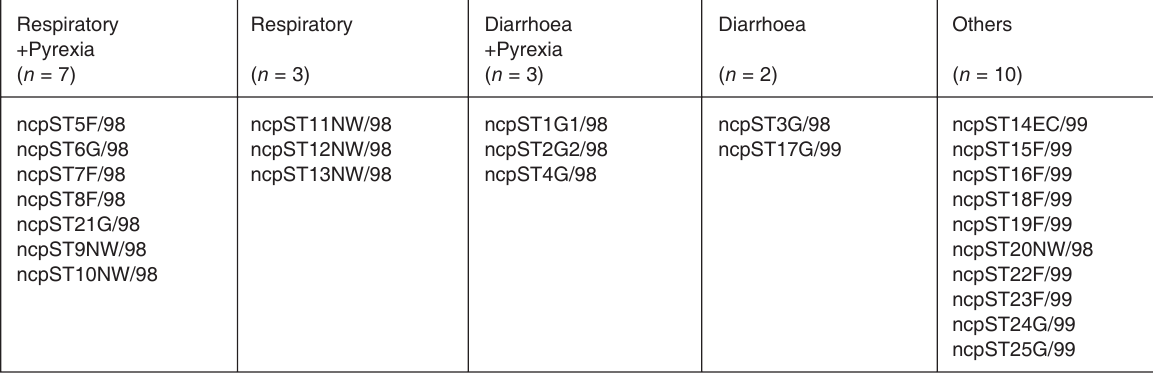
TABLE 2 Predominant clinical syndrome associated with BVDV isolates and their origin